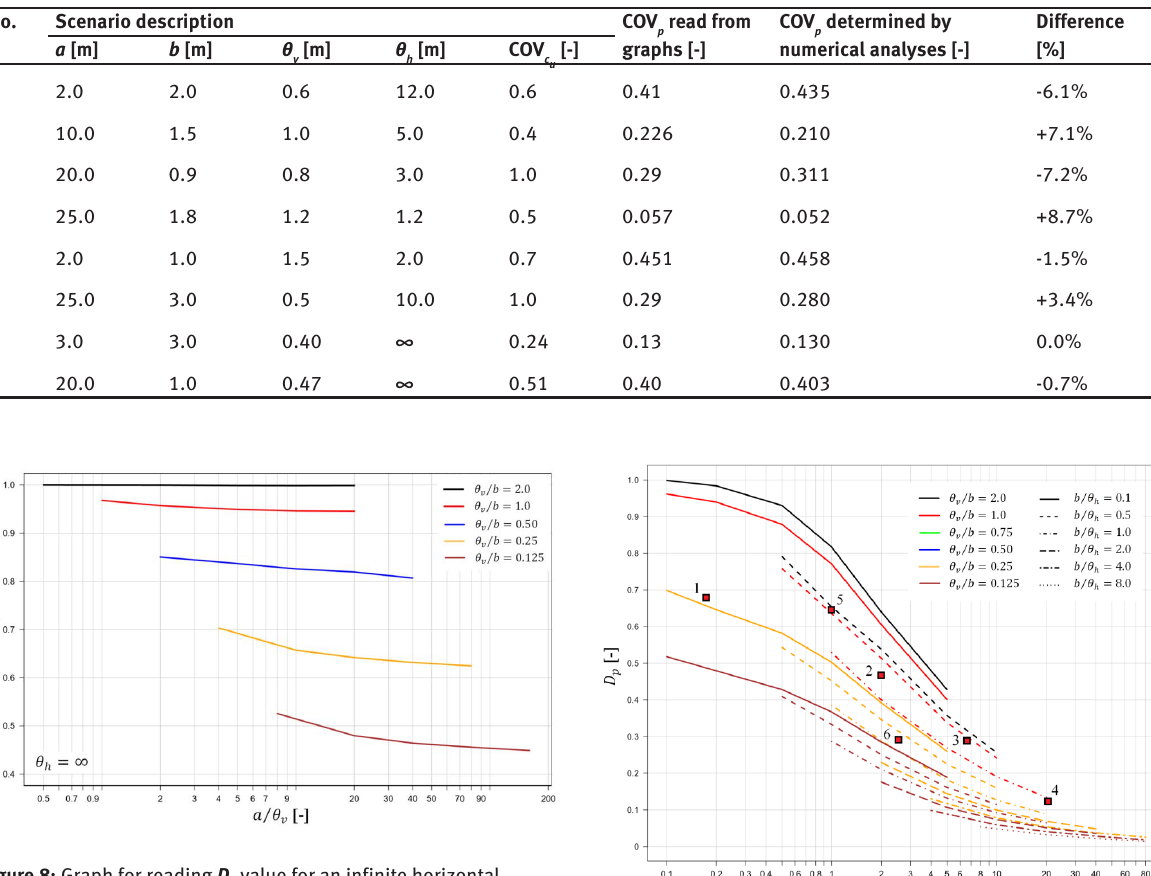
Figure 8: Graph for reading D fluctuation scale.